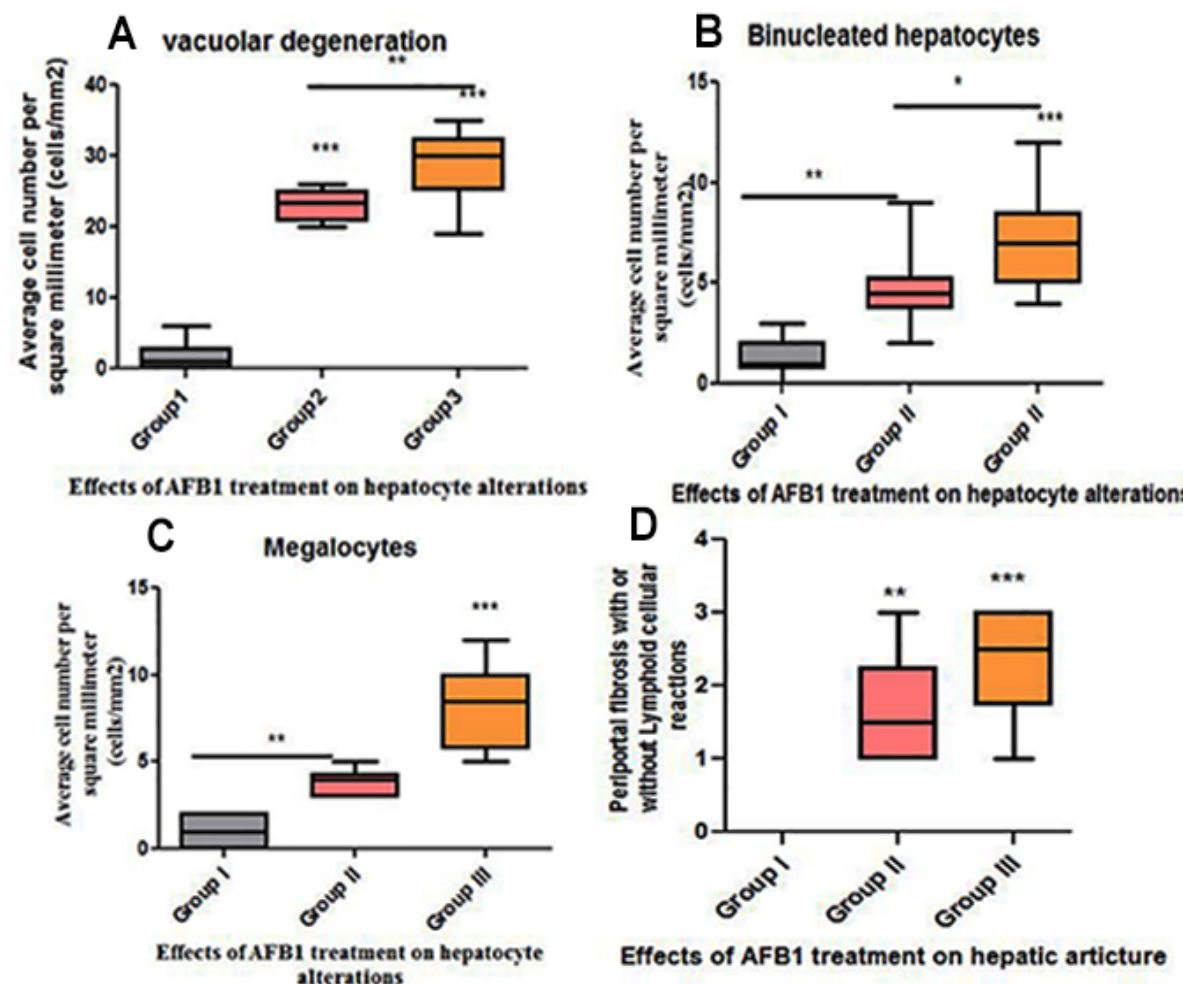
Figure 5. Histomorphometry graph showing semiquantitative measurements of hepatocyte changes among experimental groups. ( A ) Vacuolar degeneration; ( B ) binucleated hepatocytes; ( C ) average megalocytes (cells/mm 2 ) among the groups; and ( D ) periportal fibrosis score with or without periportal lymphocytic cellular reaction. Data are expressed as means ± standard deviations. Significant differences vs. the control group are marked by different asterisks through one-way ANOVA with Tukey’s post hoc test: * p ≤ 0.05, ** p ≤ 0.01, *** p ≤ 0.001 ).